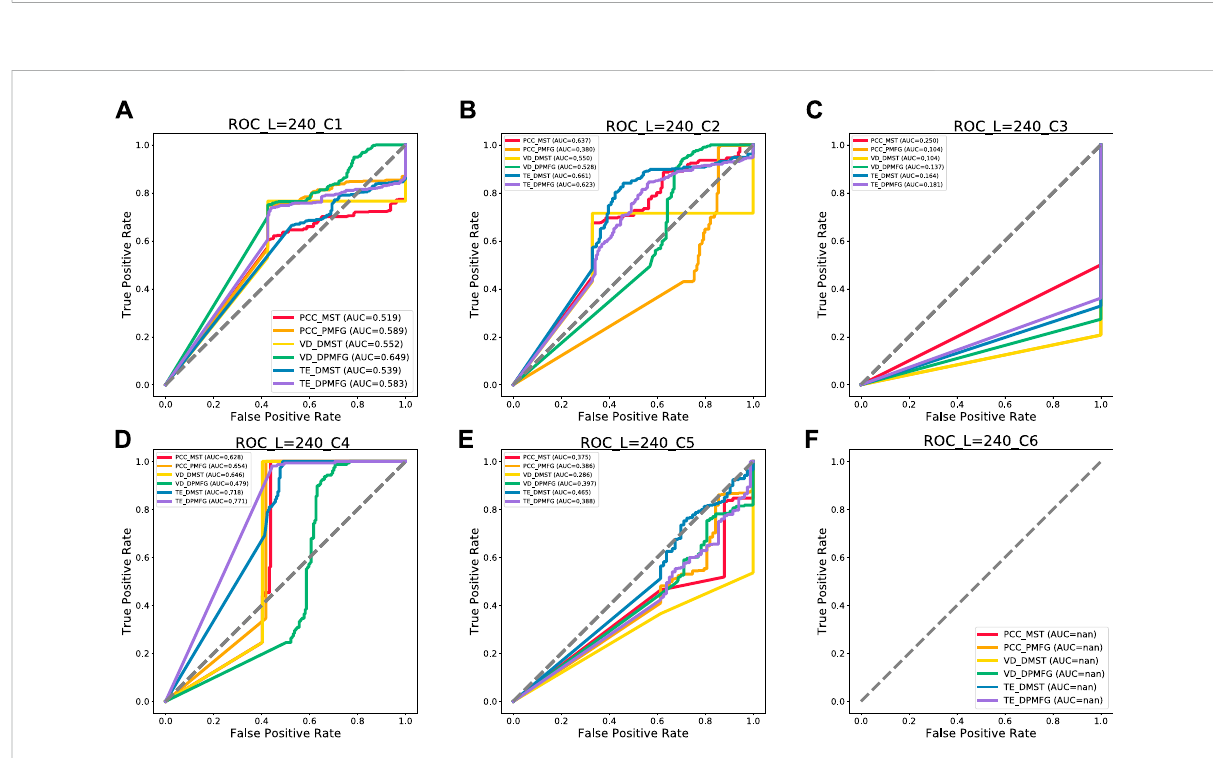
FIGURE 17 Prediction results of each layer of the network at 240-day windows. (A – F) indicate prediction result of each fi nancial crisis. C1 – C6 indicate the following crises: Subprime Mortgage Crisis, European Sovereign Debt, Russian Recession, Stock Market Selloff, and Trade Con fl ict between China and the United States, US stock circuit breaker,